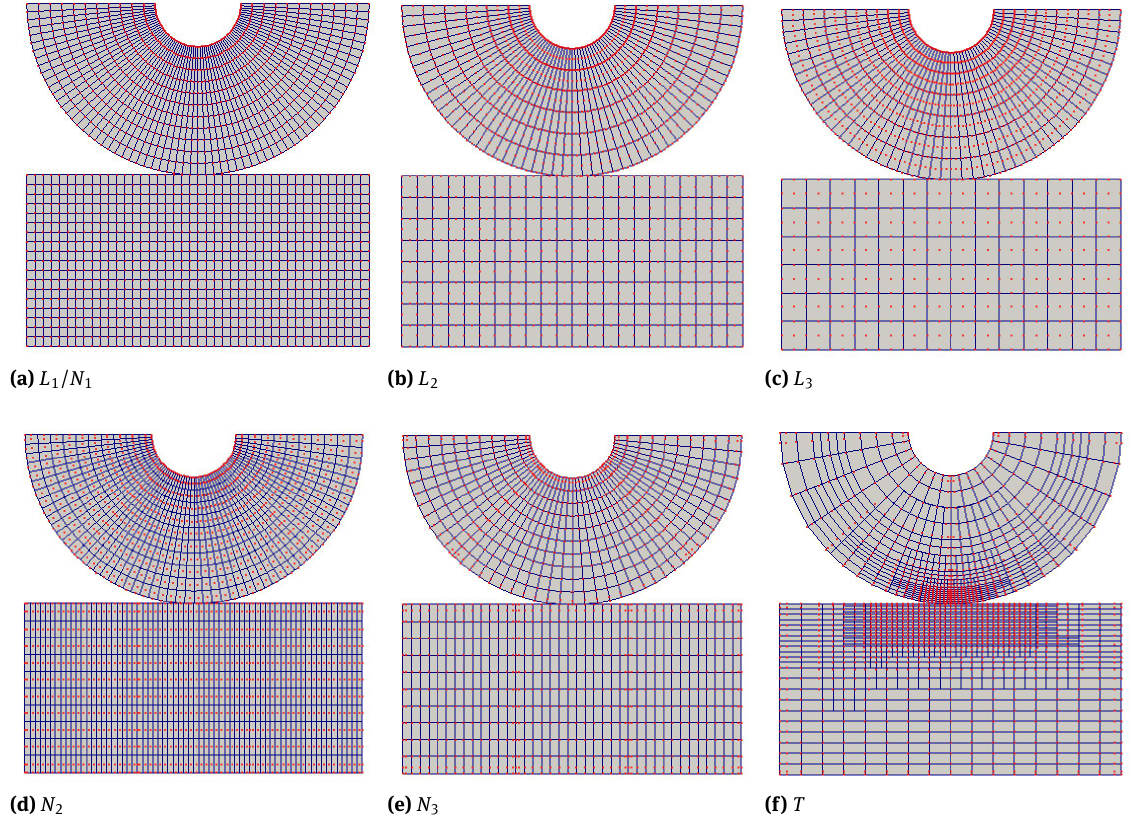
Figure 9: Ironing problem: Lagrange, NURBS, and T-spline meshes. Dof = 3352